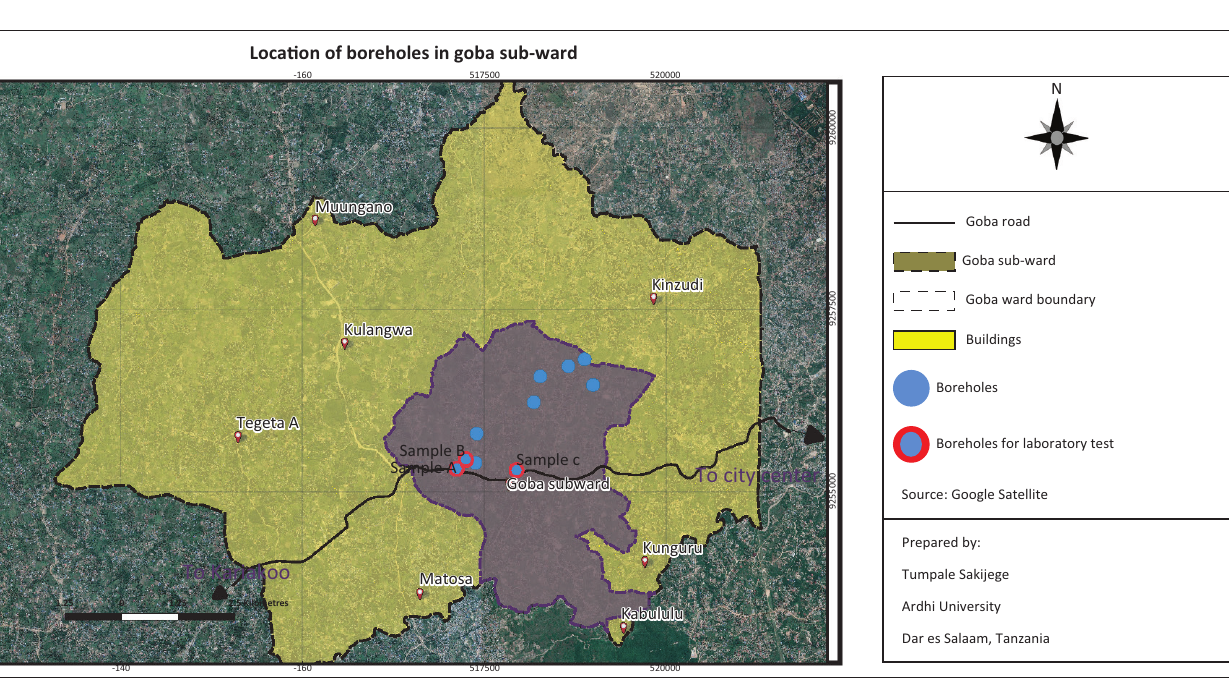
FIGURE 6: Location of boreholes in Goba